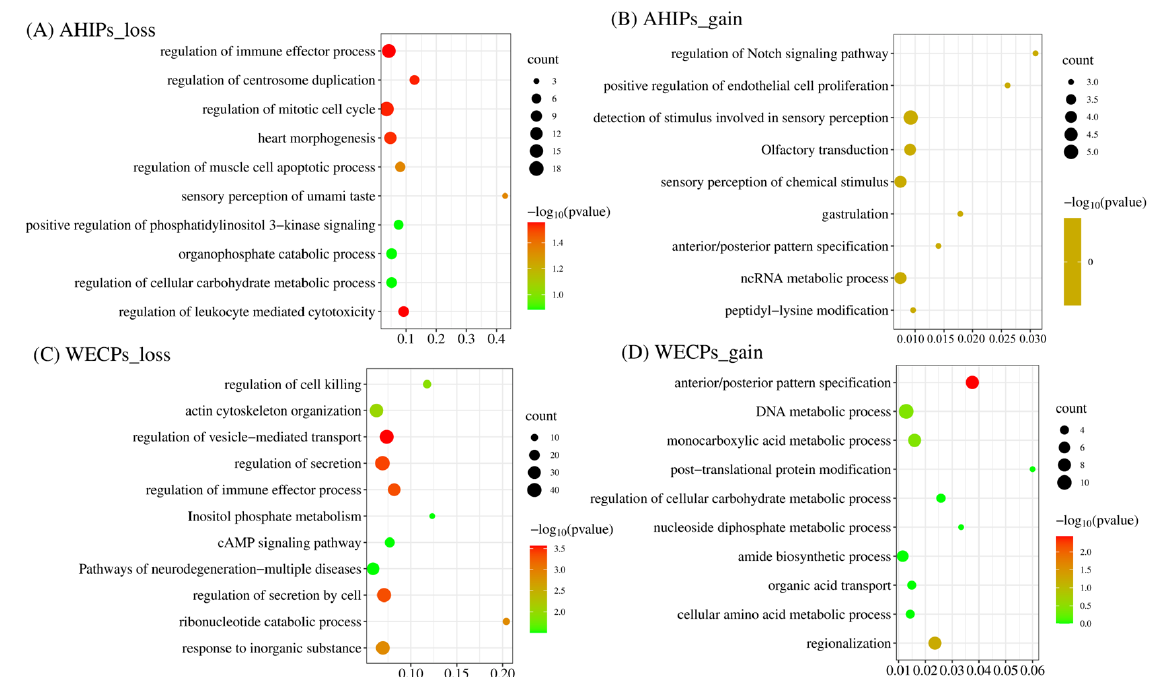
Figure 5. GO and KEGG pathways analysis of the annotated genes in CNVR in the AHIP and WECP populations, and the green to red indicate the multi-test adjusted p-value in log base 10. ( A ) The GO and KEGG pathway analysis results of annotation genes in CNVR of AHIPs_loss event. ( B ) The GO and KEGG pathway analysis results of annotation genes in CNVR of AHIPs_gain event. ( C ) The GO and KEGG pathway analysis results of annotation genes in CNVR of WECPs_loss event. ( D ) The GO and KEGG pathway analysis results of annotation genes in CNVR of WECPs_gain event.